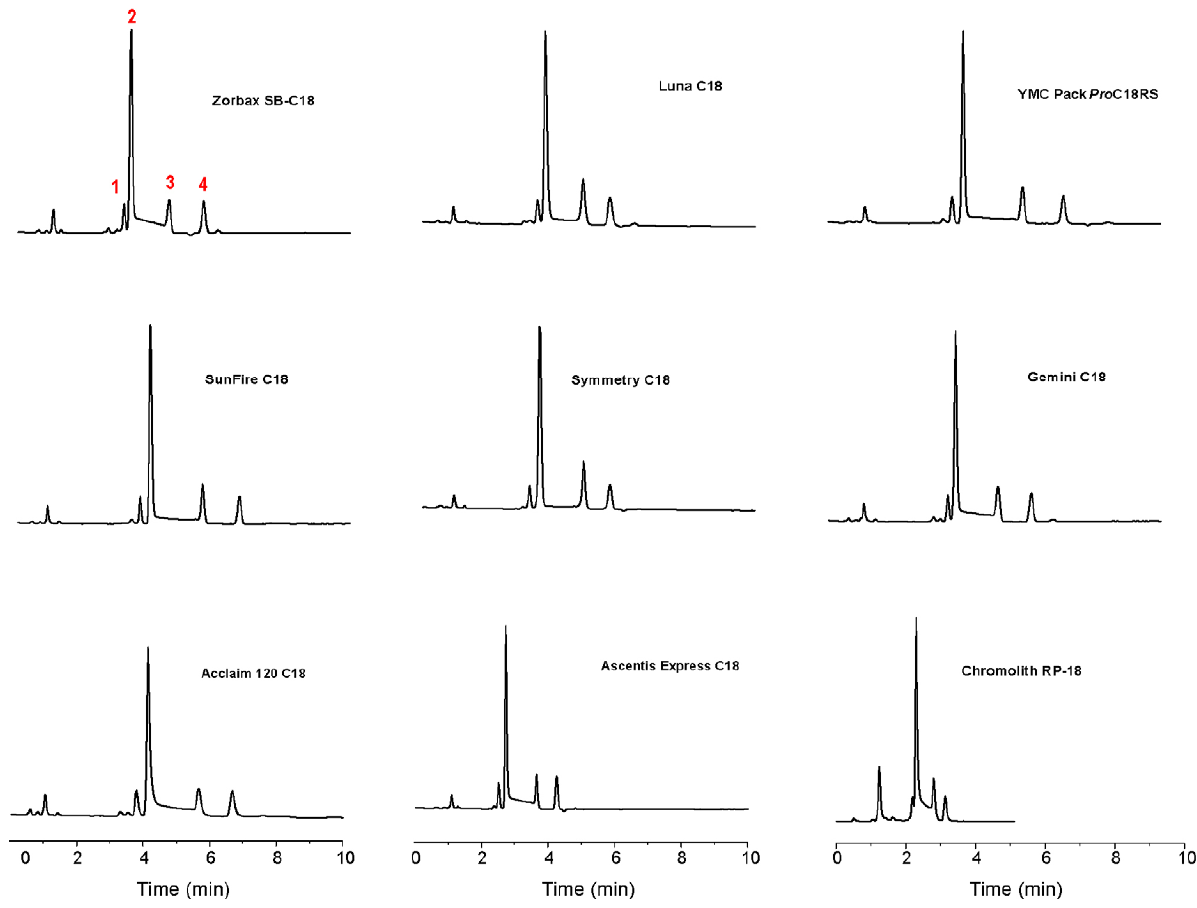
Figure 6. Typical room temperature chromatograms obtained for a standard mixture of 1 and 2 (containing 7 as impurity). Peak 1 corresponds to 7 , peak 2 to the 2 α -epimer, peak 3 to the 2 β -epimer, and peak 4 to 1 . Reproduced from Figure 3 in Reference [41] with permission from Elsevier. Copyright